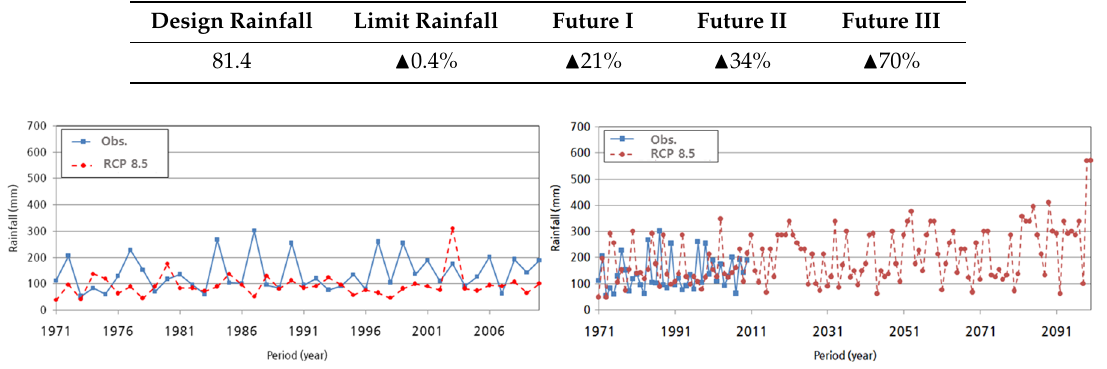
Figure 6. Comparison of rainfall observations and climate change scenarios at Incheon, Korea. ( a ) Reference period; ( b ) Projection period (bias correction by the Quantile Mapping Method).